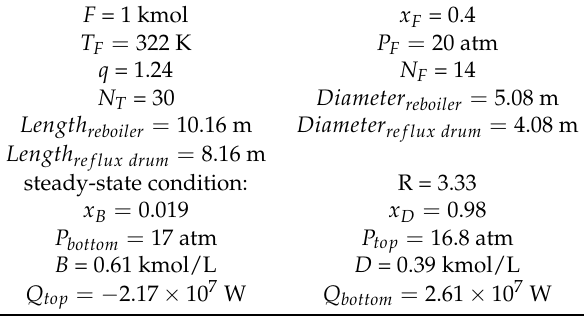
steady-state condition: R = 3.33 x B =